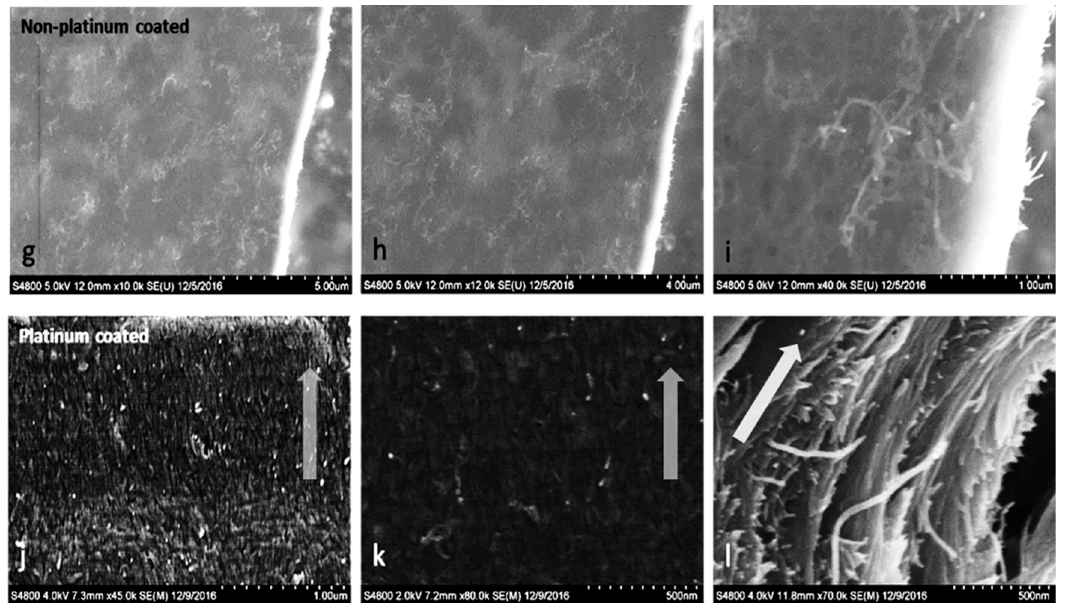
Figure 6. SEM images of 2% MWNT and 98% CNC hybrid films. ( a – c ) Images of a droplet dried hybrid film without platinum coating. ( d – f ) Images of a sedated dried hybrid film with platinum coating. ( g – i ) Blade-coated film without platinum coating. ( j – l ) Images of images of a blade-coated film with platinum coating. The arrow represents the blade shear direction. (The image contrast has been adjusted from the original image to better show the structure formation.)